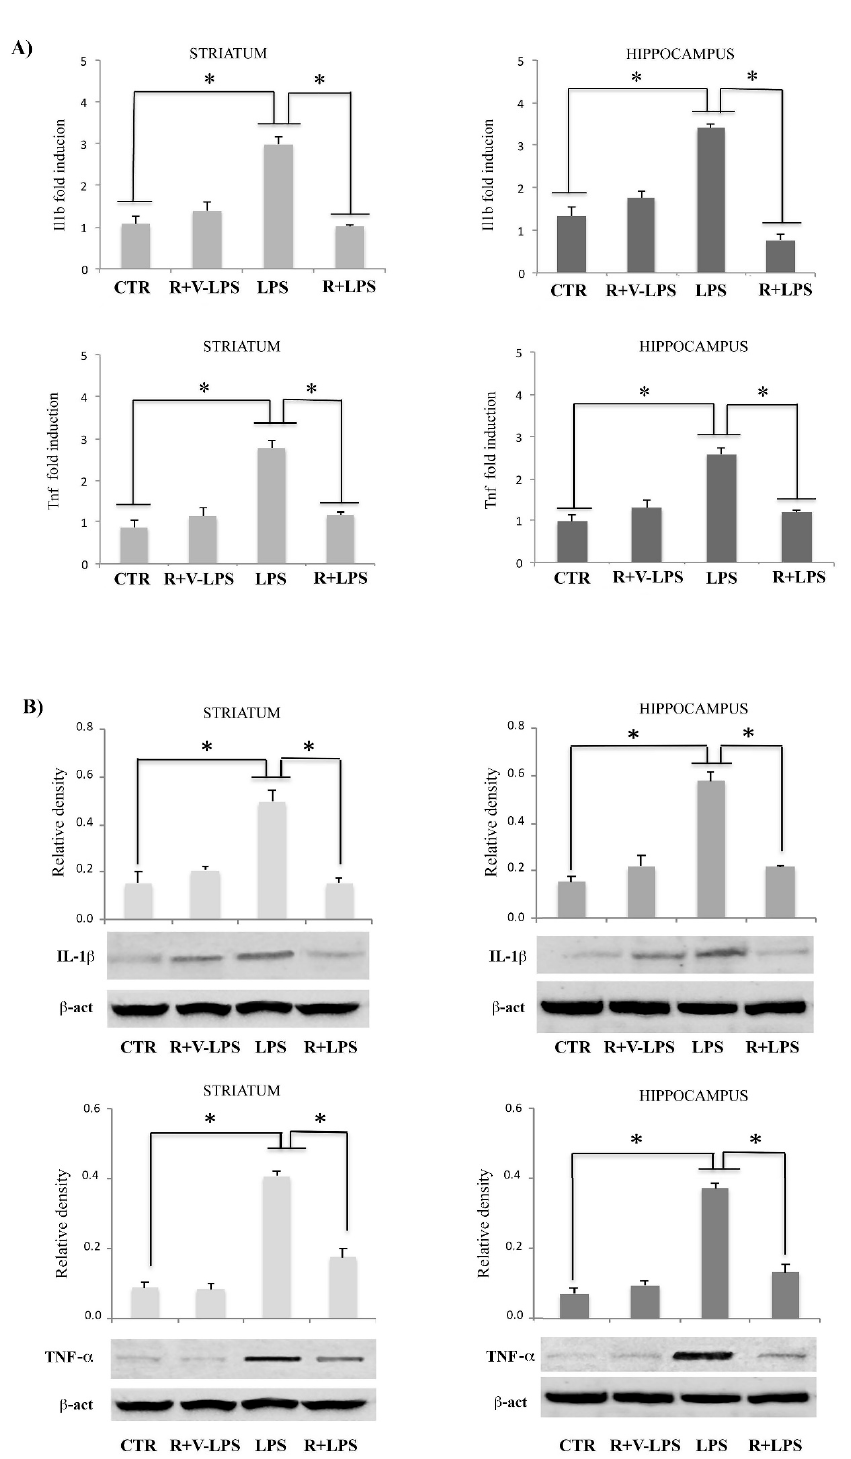
Figure 3. Real-time polymerase chain reaction (PCR) analysis of Il1b (upper) and Tnf (lower) mRNA expression ( A ); Western blotting detection and densitometric analysis of IL1 β (upper) and TNF- α (lower) ( B ) in the striatum and hippocampus of untreated controls mice (CTR), mice treated resveratrol and LPS vehicle (R+V-LPS), LPS-treated mice (LPS) and resveratrol plus LPS-treated mice (R+LPS). For protein expression analysis values are expressed as arbitrary units after normalization against β -actin, used as a loading control. Results are shown as mRNA fold changes relative to GAPDH used as resident control. Data are represented by means ± SD ( n = 5 per group, 5 replicates). * p <